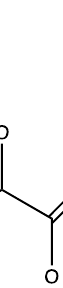
2 Figure 1. Representative disaccharide units in heparin. While there are no alkenyl groups present in heparin, the alkylation of the carbox- ylate groups can be carried out on the readily available benzalkonium salt of heparin. We